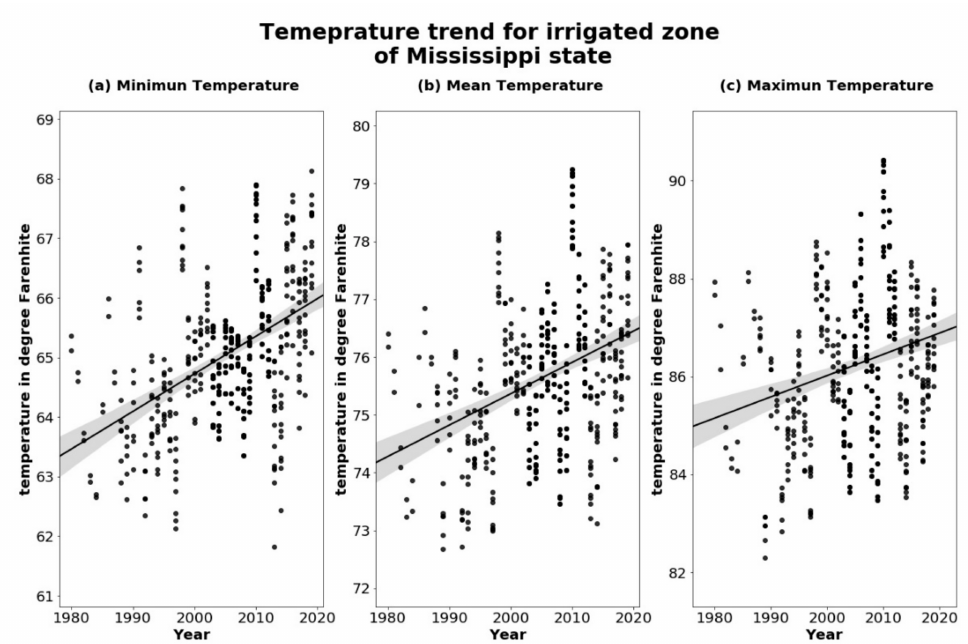
Figure 3. Trends for ( a ) seasonal minimum temperature, ( b ) mean temperature, and ( c ) maximum temperature, for the irrigated zones of the Mississippi State from 1980 to